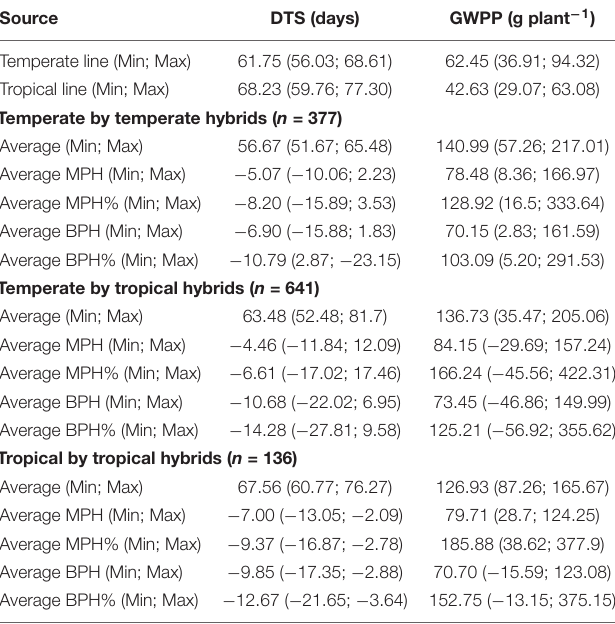
TABLE 1 | Summary statistics for tested traits (GWPP and DTS) and their heterosis.